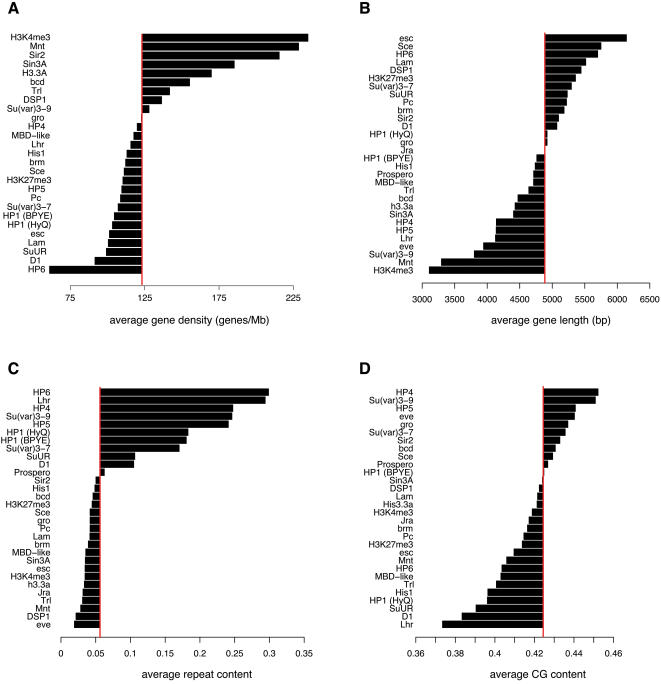
Sequence properties of BRICKs.For each type of BRICK (defined by a single chromatin component) the average value is plotted for A) gene density; B) gene length; C) fraction of repetitive (i.e., non-unique) sequence; D) G/C content. All values are plotted as deviations from the genome-wide average (red vertical lines).